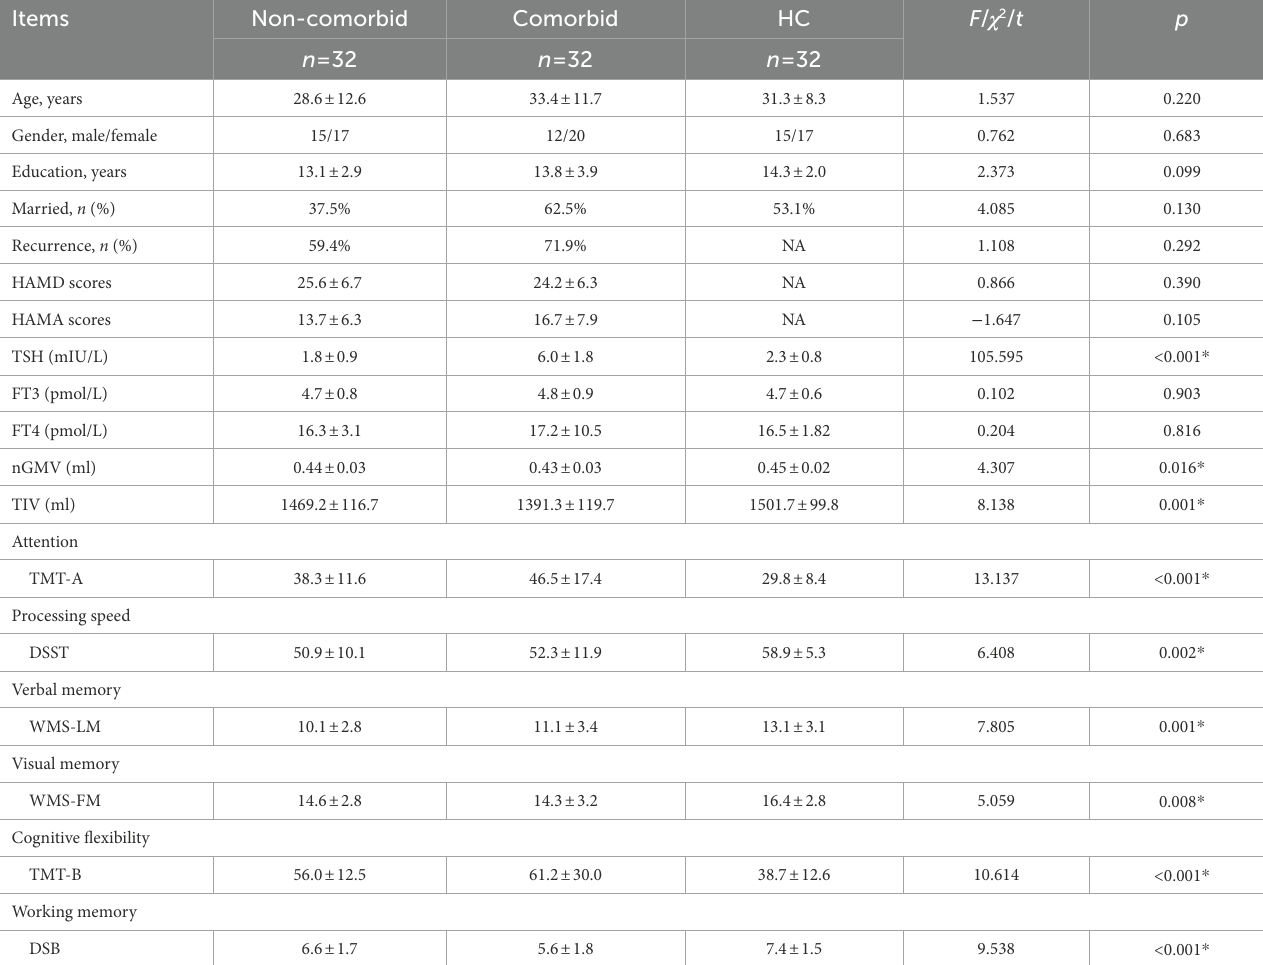
TABLE 1 The demographics, clinical characteristics, and cognitive function of the three groups of